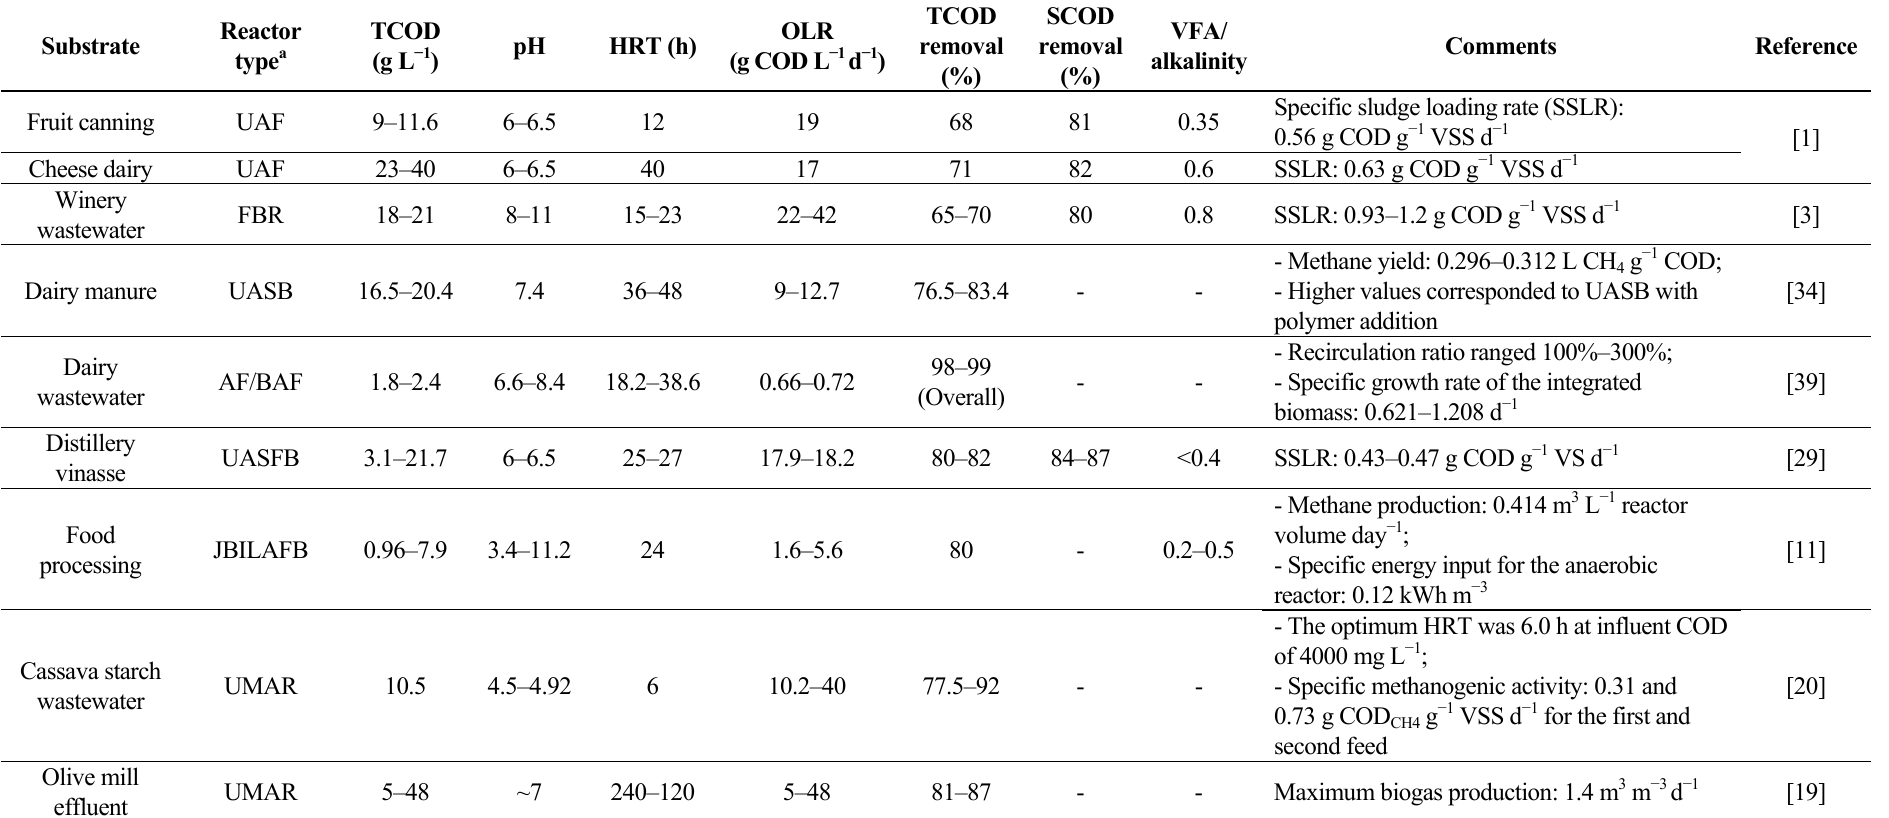
Table 2. Performance of anaerobic digesters for the treatment of various agro-food